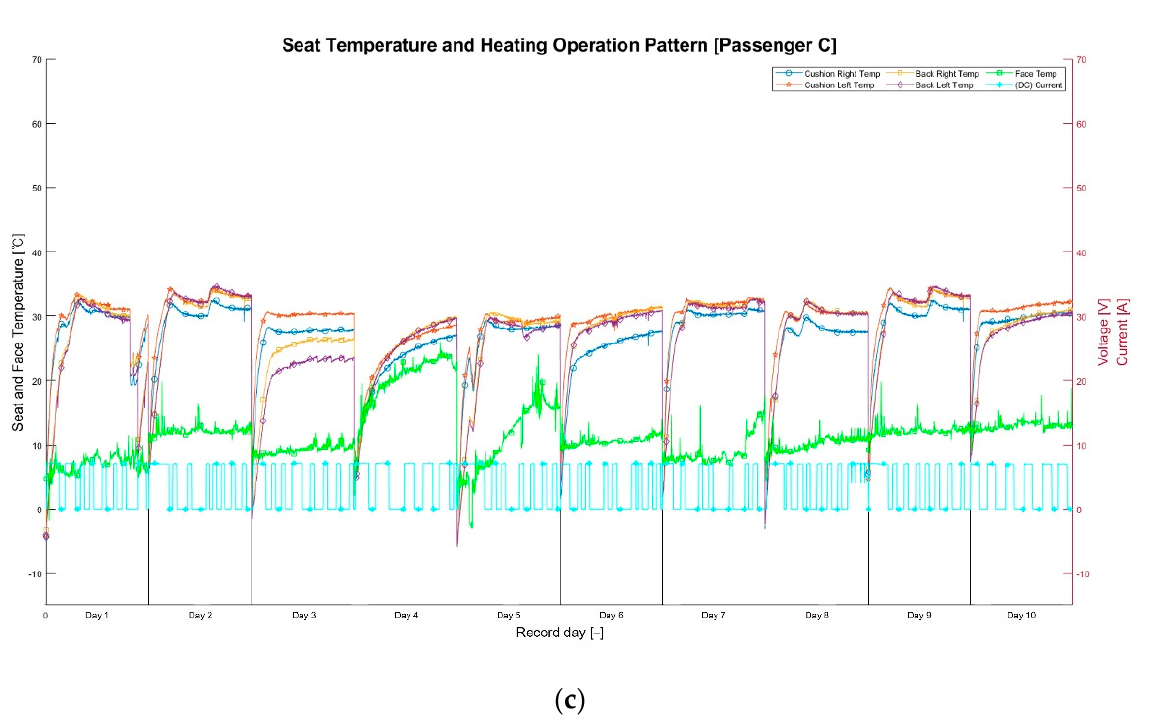
Figure 5. Seat temperature data of a vehicle: ( a ) passenger A; ( b ) passenger B; and ( c ) passenger C.